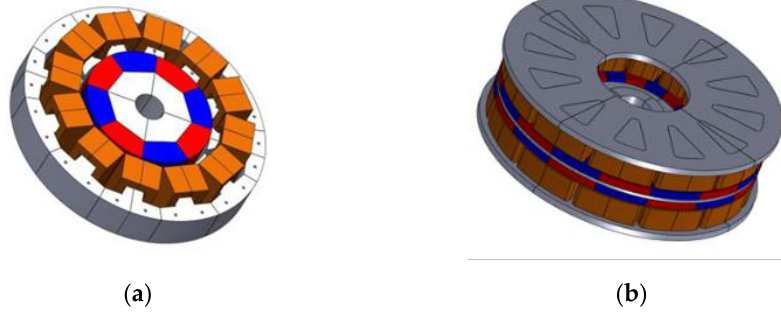
Figure 1. Motor structures: ( a ) radial-gap motor; ( b ) axial-gap motor.